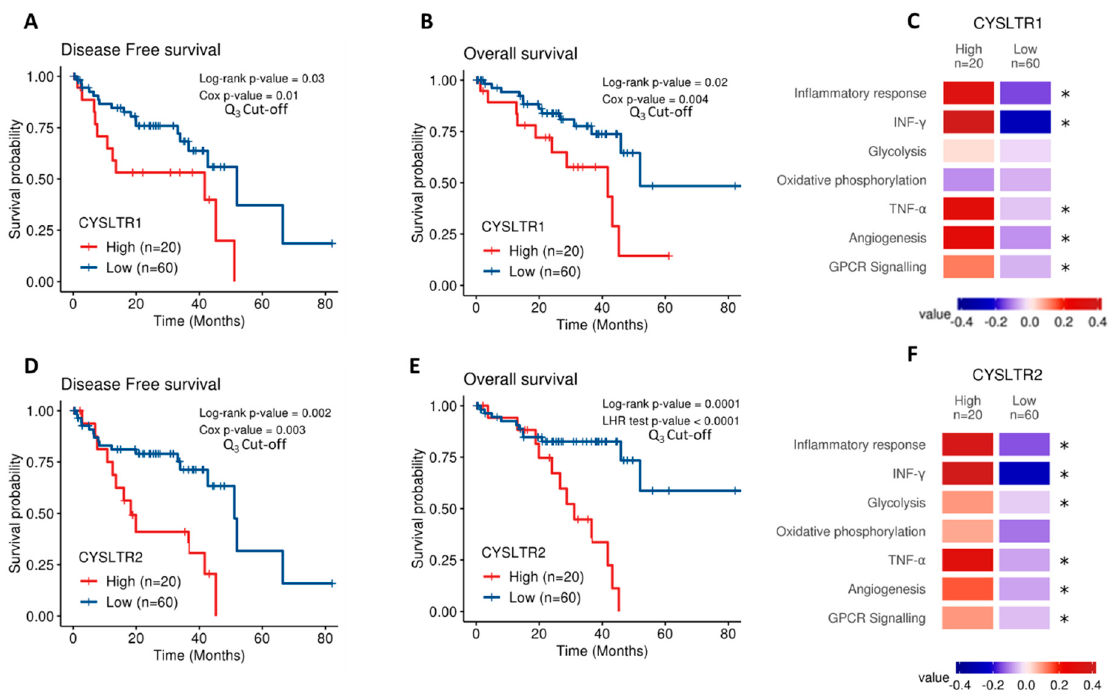
Figure 1. Analysis of CYSLTR1/CYSLTR2 expression and UM patient survival from The